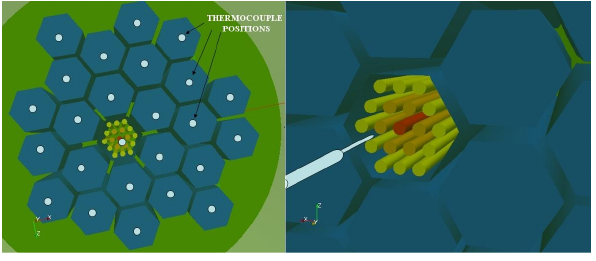
Figure 2. Subassembly